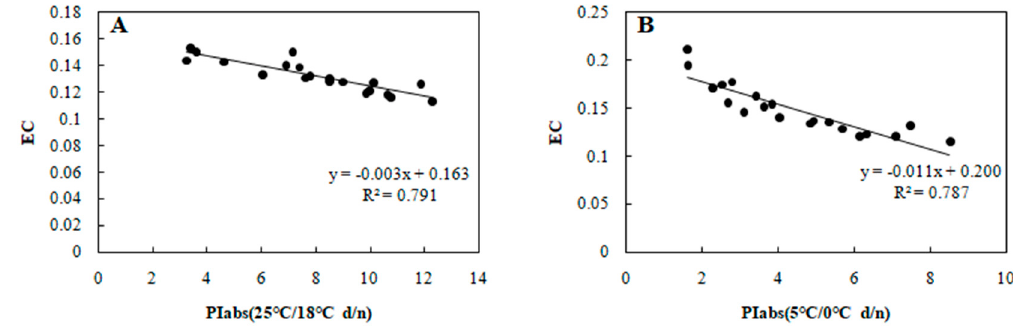
Figure 5. Correlation between PIabs and EC in 20 wucai genotypes measured in ( A ) 25/18 °C (d/n) treatment and ( B ) 5/0 °C (d/n) treatment.